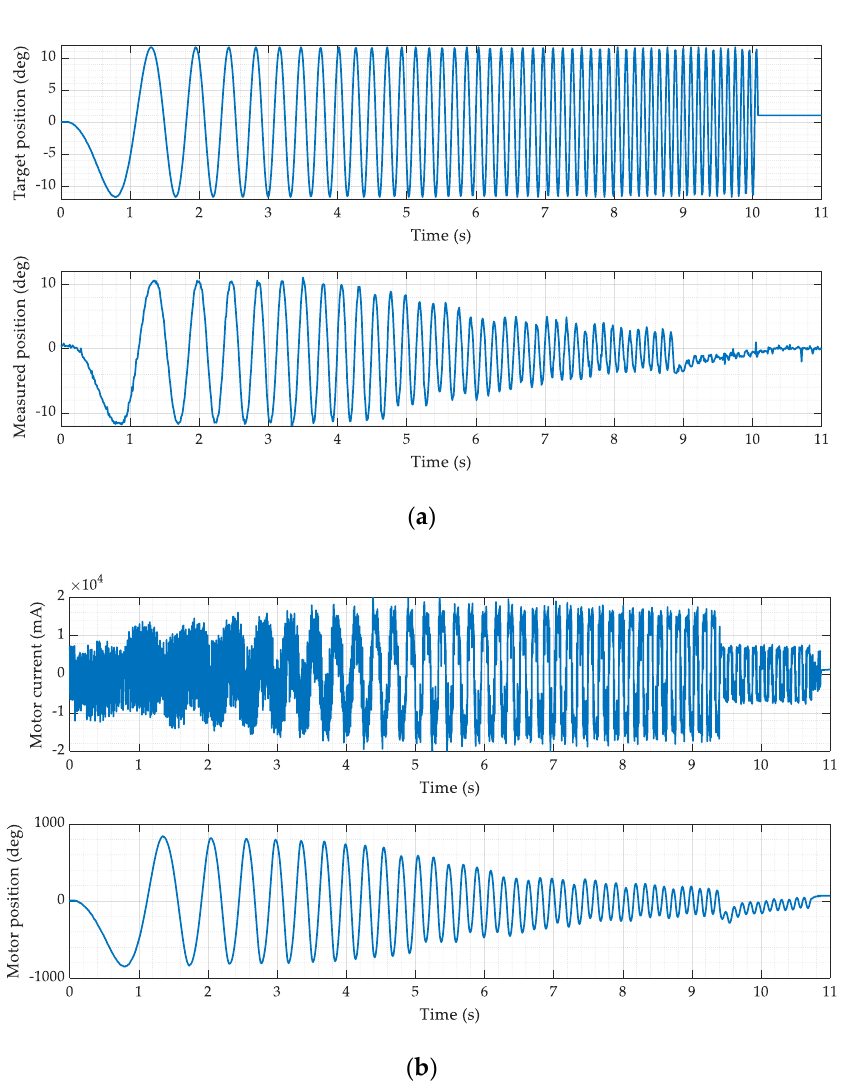
Figure 6. Sine-sweep steering maneuver — suspended vehicle, 0 – 10 Hz, amplitude 10 degrees. ( a ) Reference steering wheel position and measured response by the steering encoder. ( b ) Measured motor current and position.